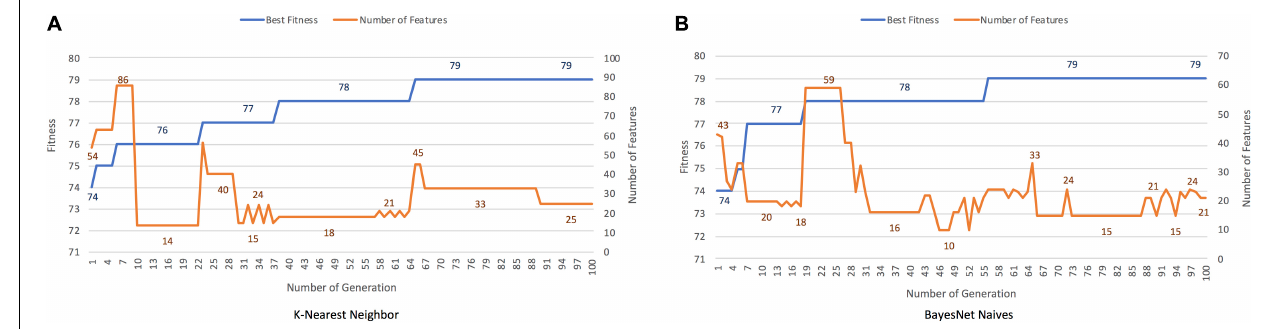
FIGURE 6 | Results for PPA, with K-Nearest Neighbor (A) and BayesNet Naive s (B) as the fitness function. The X axis represents the generation, the main Y axis corresponds to the fitness value, and the secondary Y axis shows the features selected. The blue line represents the progression of fitness and the orange line the smallest set of features in the current